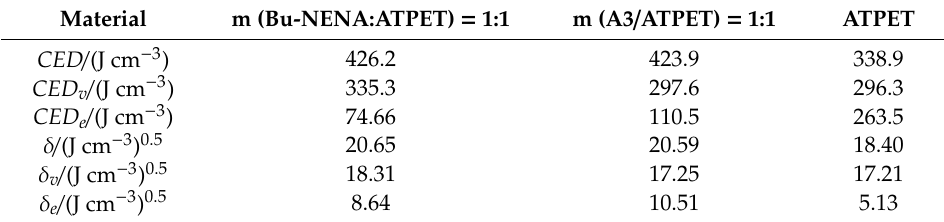
Table 2. Cohesive energy density ( CED ) and δ of PTPET with Bu-NENA and A3.